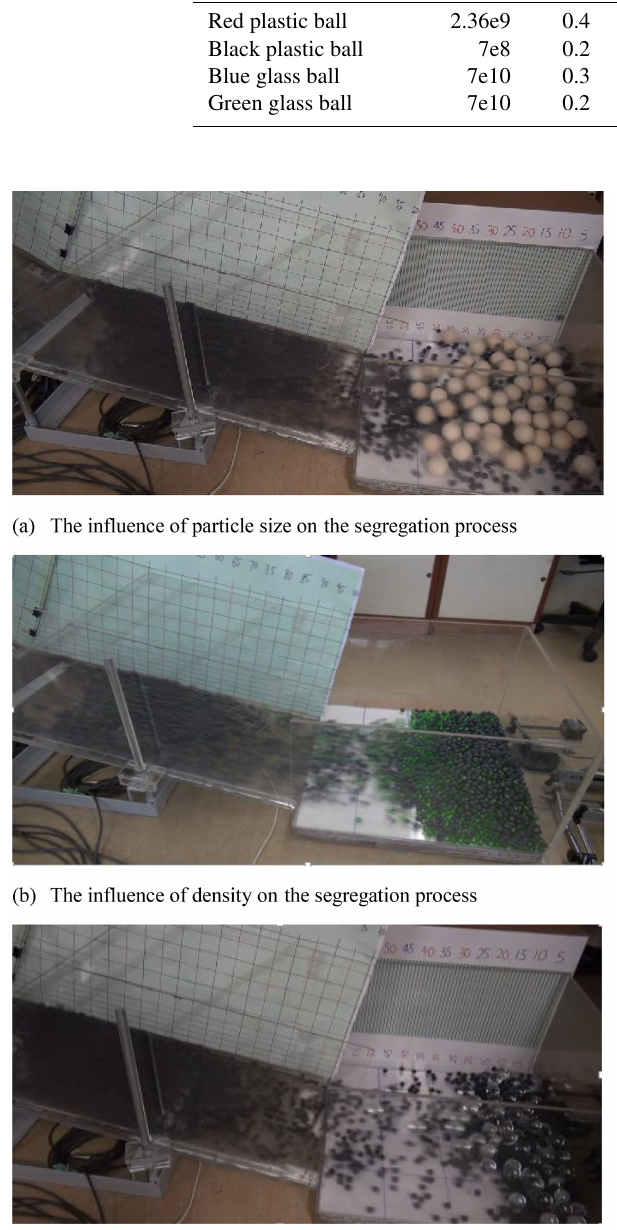
Figure 8. Flow pattern of multi-size particle flow.